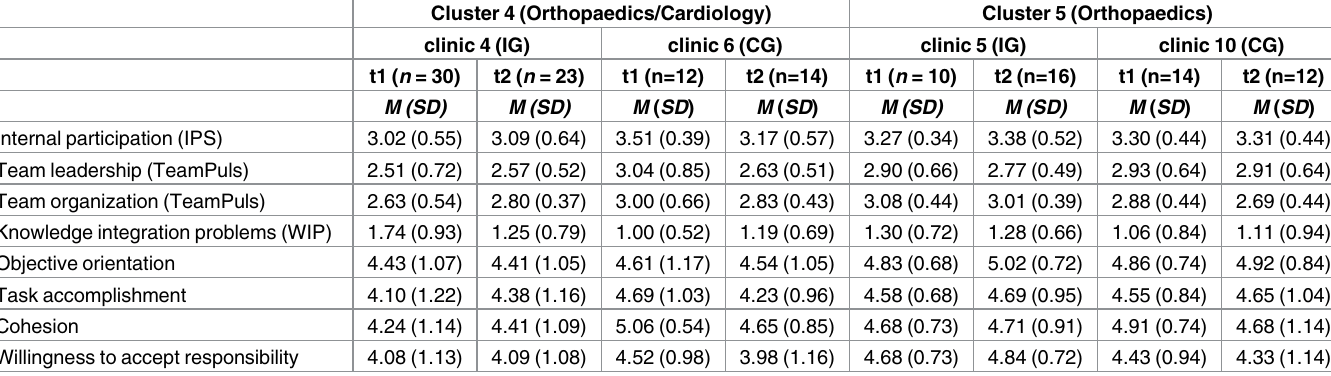
Table 6. Clinic specific means of outcome criteria of the staff survey (Cluster 4 and